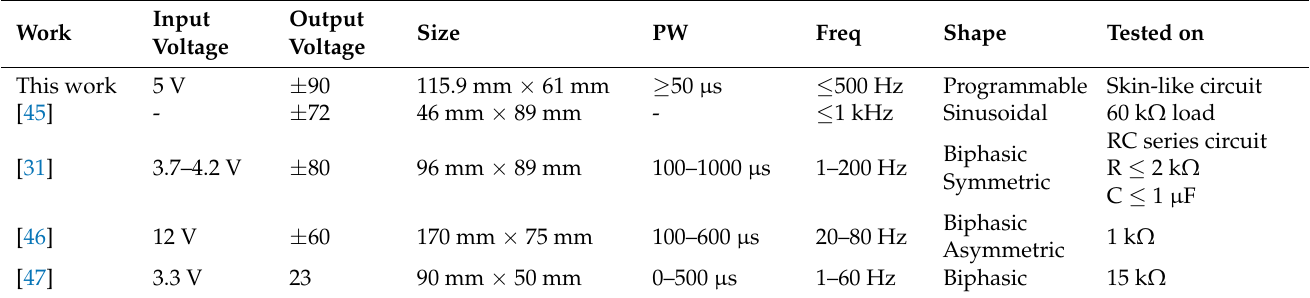
Table 1. Comparison of our work with selected stimulators in the